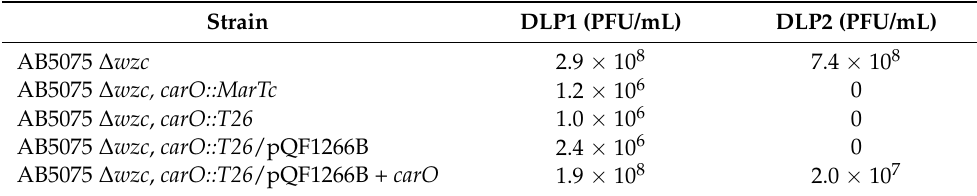
Table 2. Infection characteristics of DLP1 and DLP2 against carO mutants. Strain DLP1 (PFU/mL) DLP2 (PFU/mL) 2.9 × 10